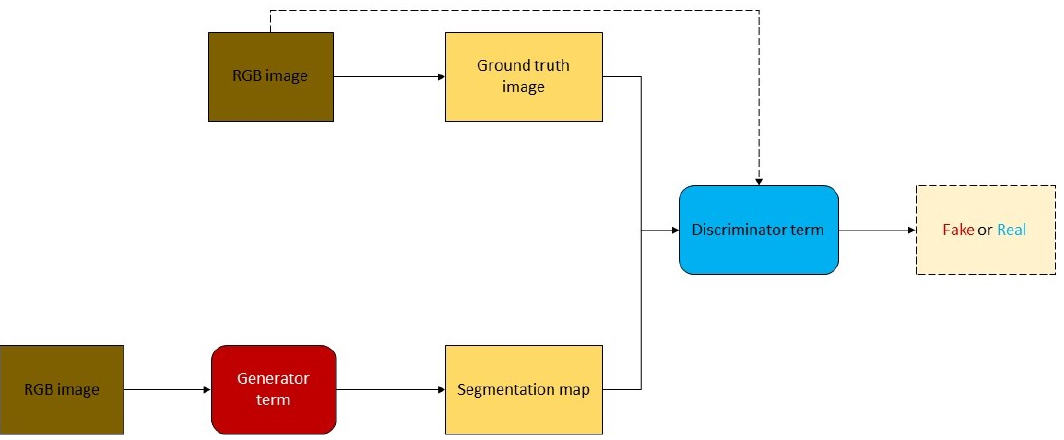
Figure 6. Generic architecture of GANs model.